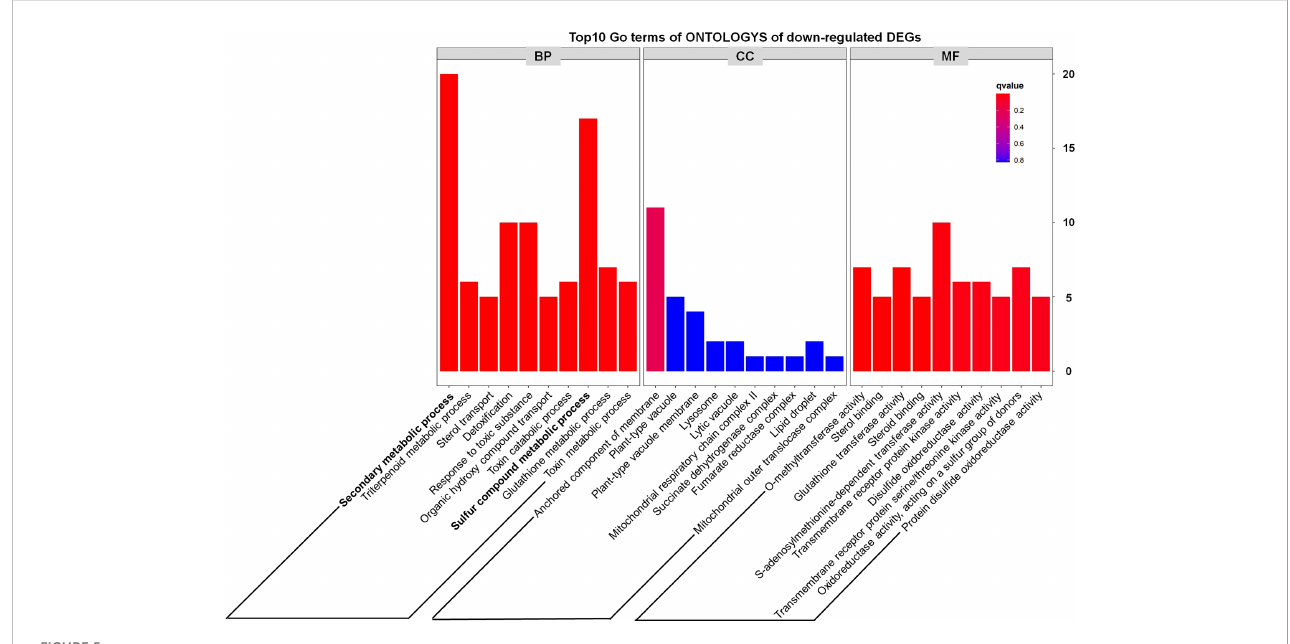
FIGURE 5 GO classi fi cation results of down-regulated DEGs.